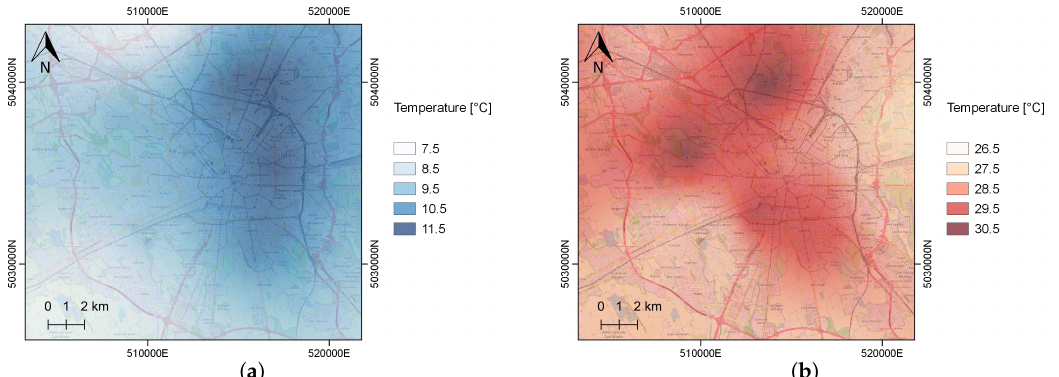
Figure 7. Temperature maps from the ordinary Kriging interpolation of the weekly average air temperature observations: Example of non-vegetative period ( a ) and vegetative period ( b ). Weekly averages were computed using the whole hourly observations for the week 11–17 January 2016 ( a ), and the week 20–26 June 2016 ( b ). CRS: WGS84/UTM zone 32